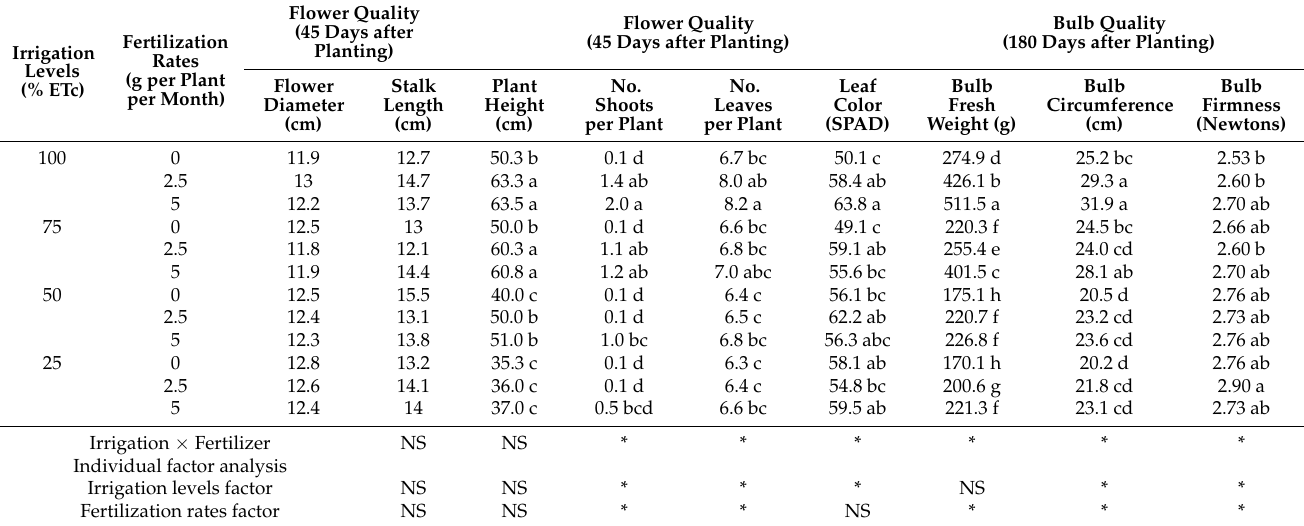
Table 4. Plant growth, flower quality, and bulb quality of Hippeastrum ‘Red Lion’ grown under different irrigation levels and fertilization rates at the flowering stage (45 DAP), growing stage (180 DAP), and bulb harvest stage (180 DAP).